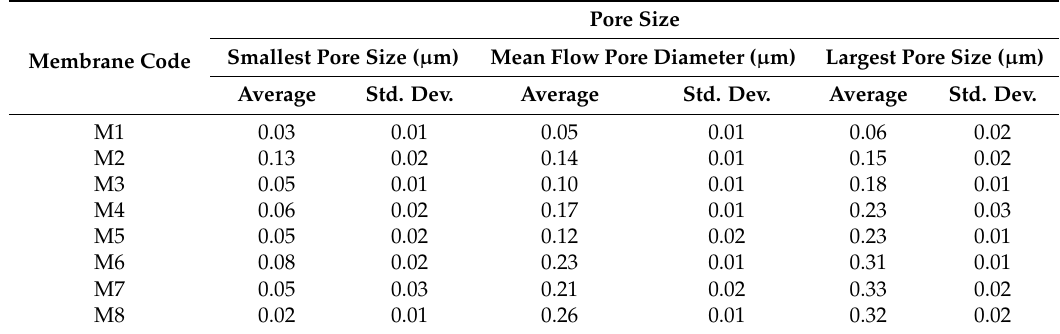
Table 3. Smallest, mean flow and largest pore diameter of the prepared